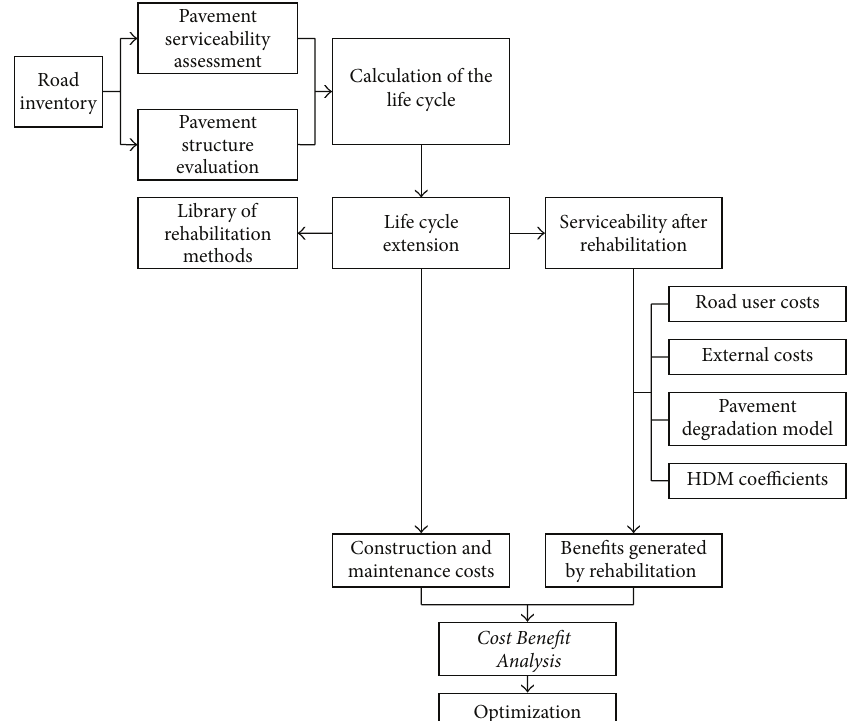
Figure 1: Flowchart: Life cycle extension of the ACM.